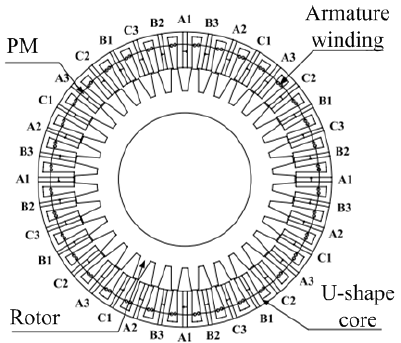
Figure 12. Nine-phase FSPM for a fault-tolerance